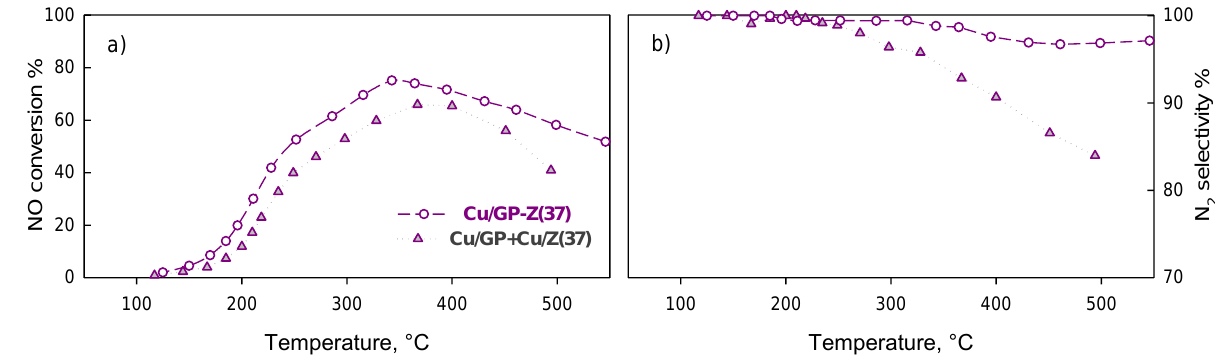
Figure 7. ( a ) NO conversion and ( b ) N 2 selectivity as a function of the reaction temperature during the NH 3 -SCR of NO on a powdered Cu/GP – Z(37) sample and on a mechanical mixture of pure Cu/GP and Cu/Z powders with identical nominal composition.